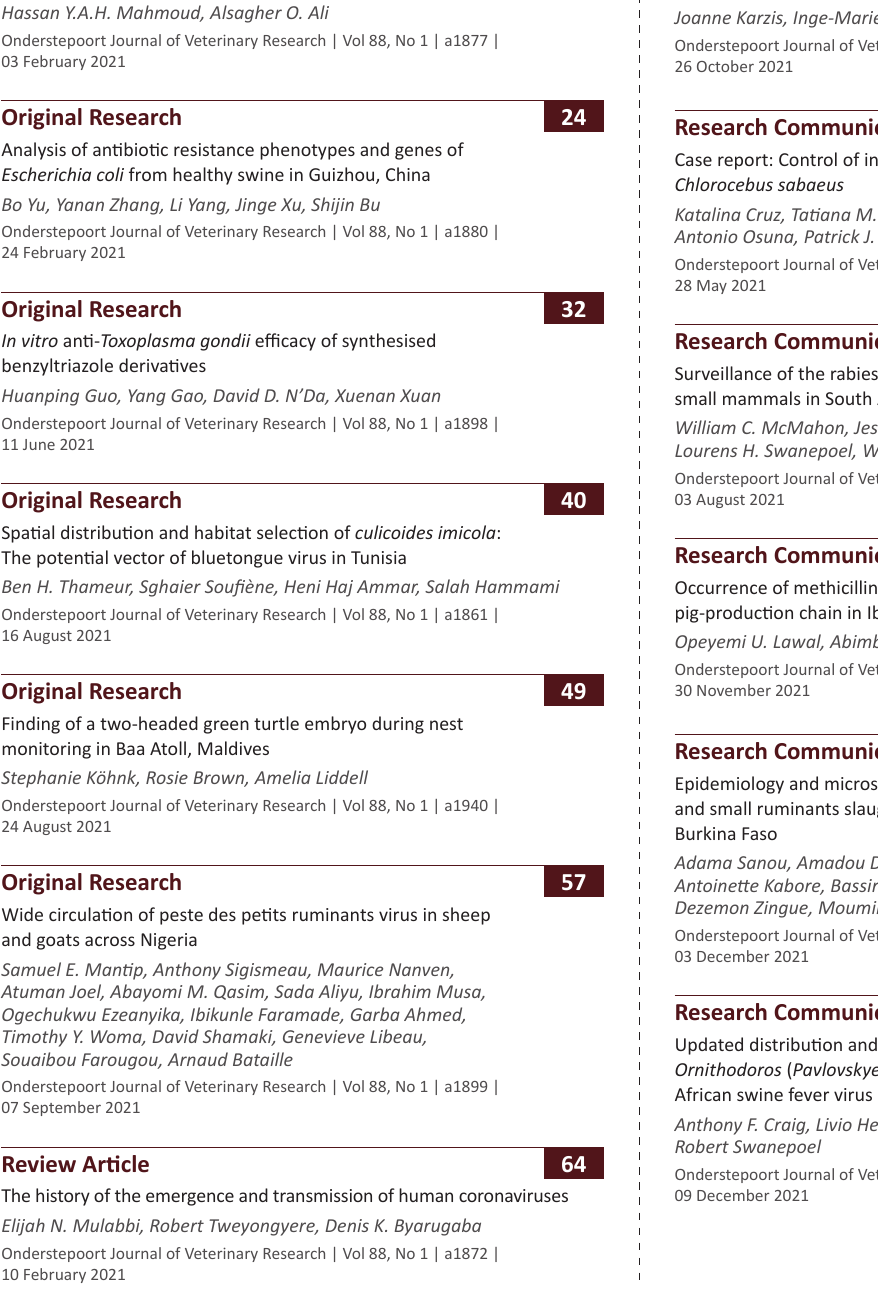
The spread and antimicrobial resistance of Staphylococcus aureus in South African dairy herds – A review